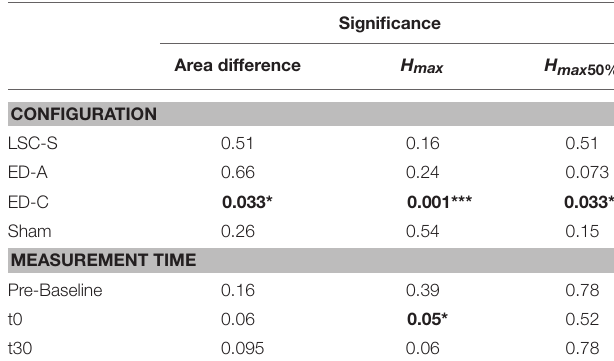
TABLE 1 | Statistical analysis of general differences within conditions and measurement times, across conditions, after Friedman repeated measures